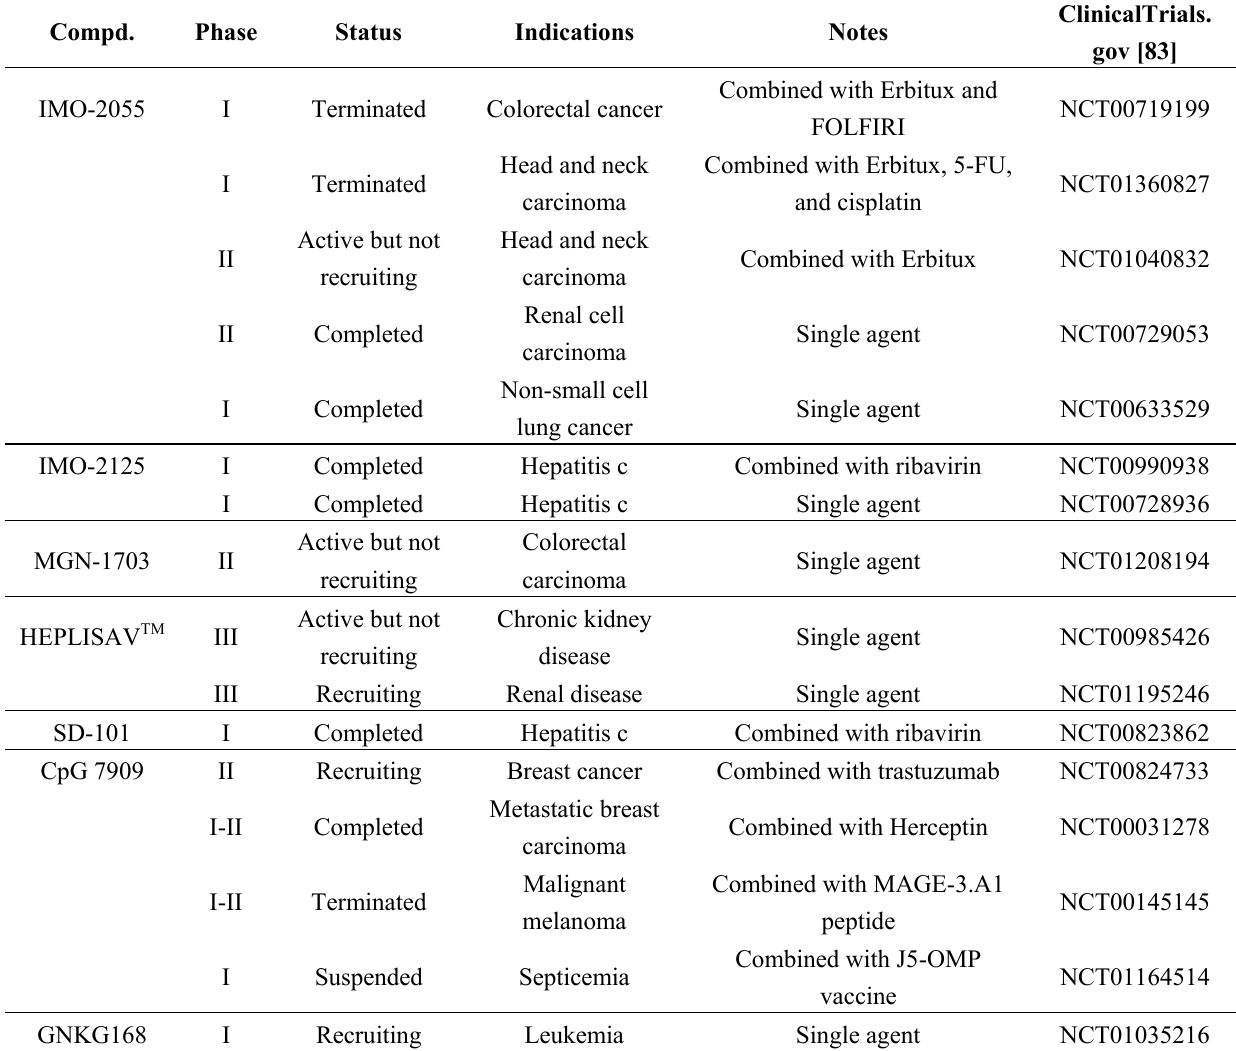
Table 3. Clinical status of TLR9-recognizing nucleic acid